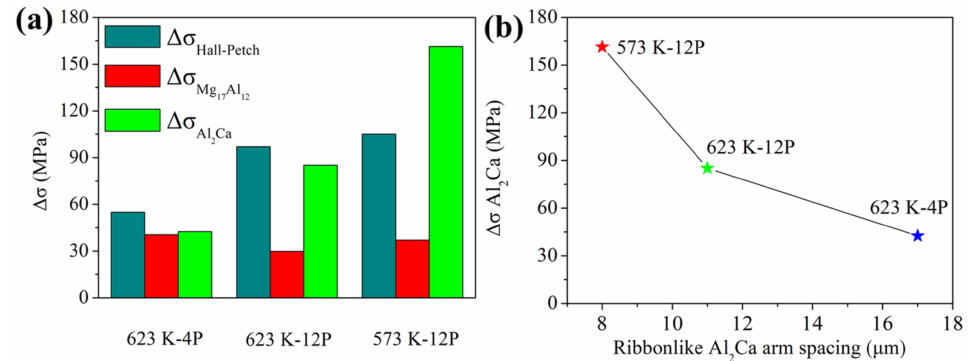
Figure 14. ( a ) The contributions of various strengthening factors to tensile yield strength of ECAP alloys. ( b ) The relationship between the ribbonlike Al 2 Ca arm spacing and the contribution of Al 2 Ca particles to tensile yield strength of ECAP